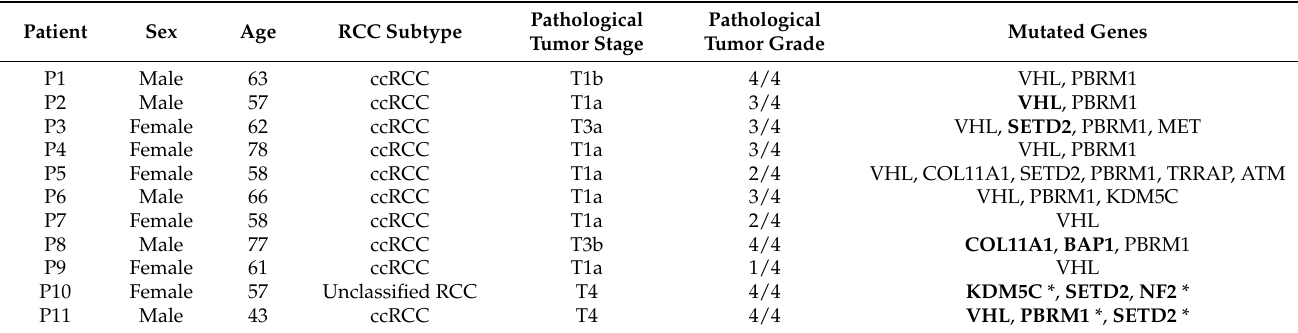
Table 1. Information about 11 enrolled patients in this study. Clinical features of tumors as well as genes affected by somatic mutations in each tumor are provided (see Table S1 for details of somatic